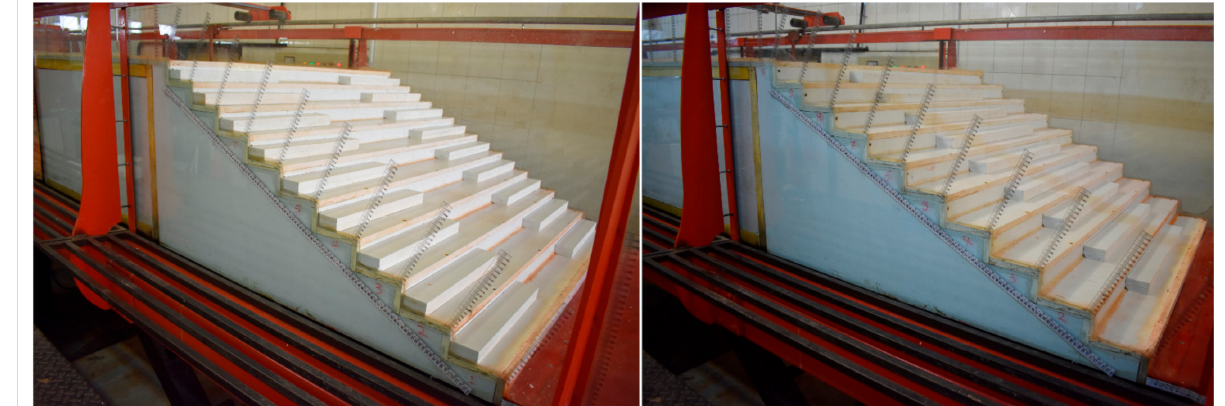
Figure 6. Schematic model of two side (AE) in left and center (AE) on steps in